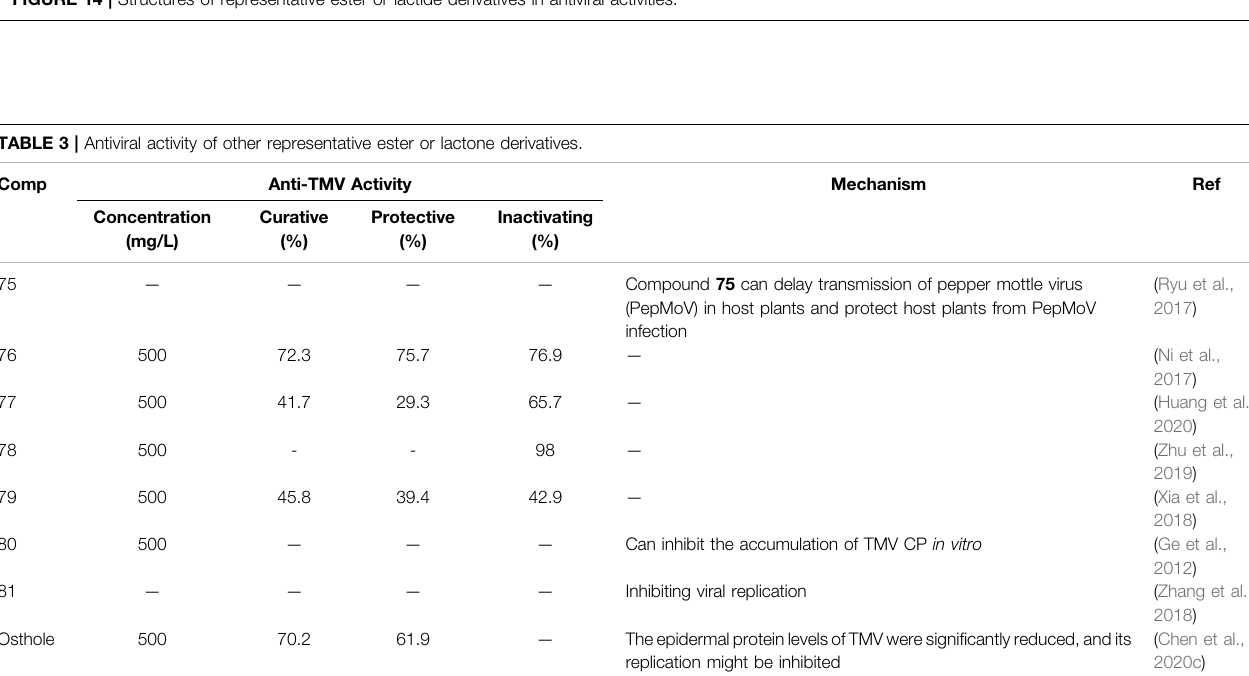
FIGURE 14 | Structures of representative ester or lactide derivatives in antiviral activities.